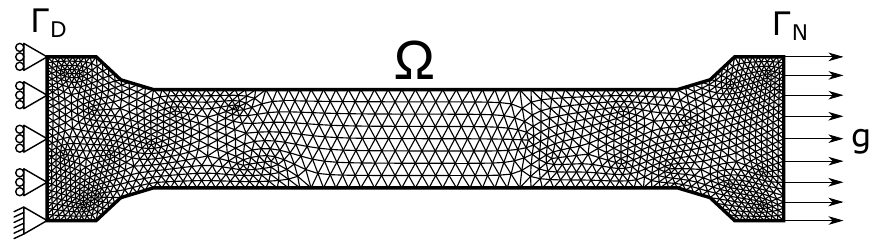
Figure 5. Physical settting and finite element mesh.